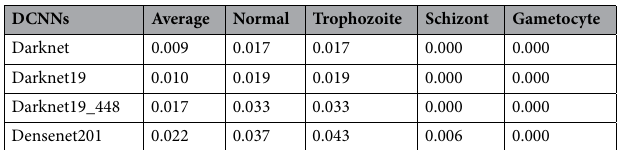
Table 4. Model-wise comparison and multiclass-wise comparison based on misclassification rate from one- class versus total.